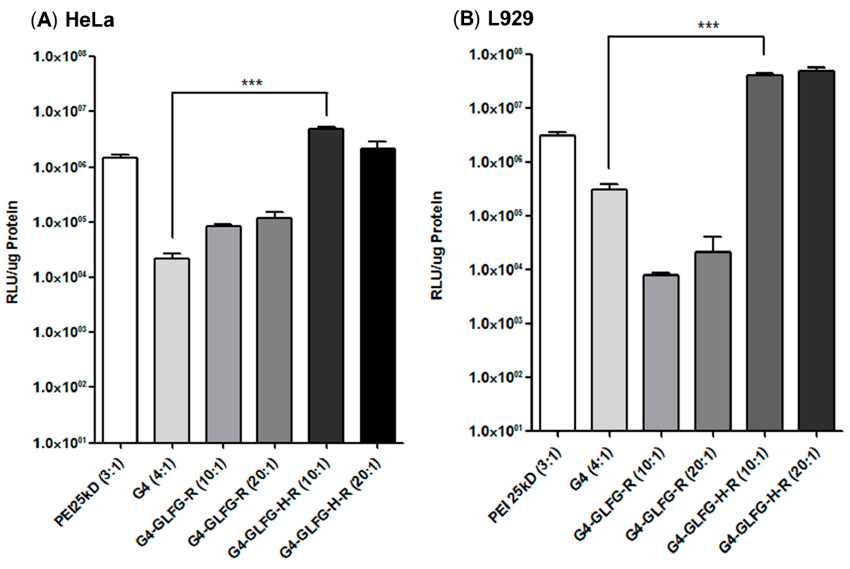
Figure 10. Transfection assay using pCN-luc reporter gene in HeLa ( A ) and L929 ( B ) cells. Data are shown as mean ± standard deviation ( n = 3). *** p < 0.001.